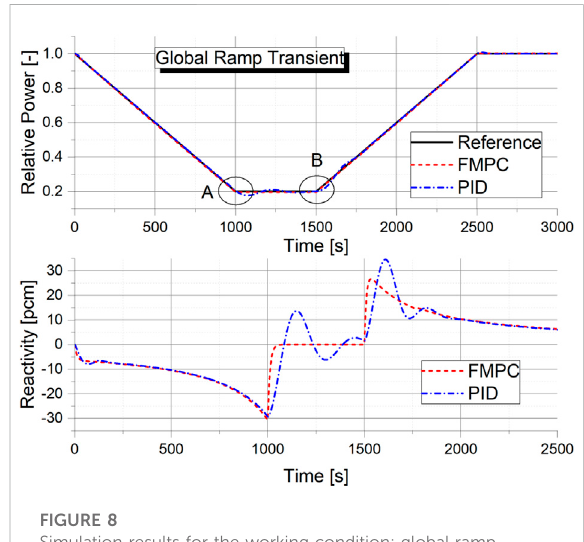
Simulation results for the working condition: global ramp